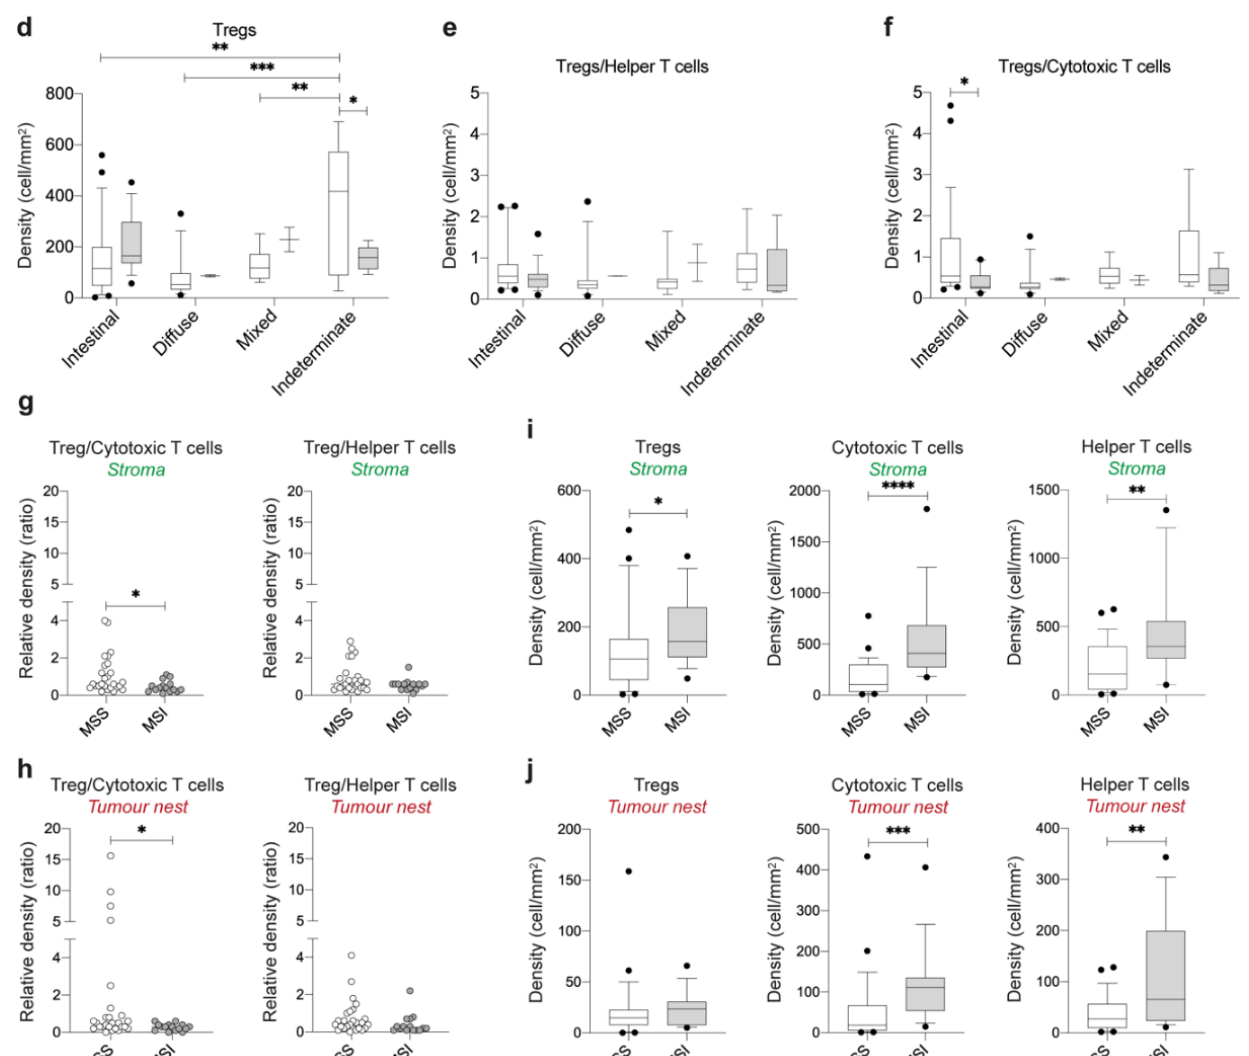
Figure 2. Distribution of T cell populations in MSS and microsatellite instability (MSI) GC tumors. ( a ) Relative and absolute frequency of MSS and MSI cases for each GC histological type. ( b – f ) Relative numbers of helper ( b ), cytotoxic T cells ( c ), Tregs ( d ), and Tregs normalized to helper T cells ( e ) and cytotoxic T cells ( f ), according to the MSI status and tumor histology. ( g , h ) Relative number of Tregs normalized to cytotoxic and helper T cells within the stroma ( g ) and tumor nest ( h ) areas of intestinal-type GC cases, according to MSI status. Relative number of Tregs, cytotoxic T cells, and helper T cells within the stroma ( i ) and tumor nest ( j ) areas of intestinal-type GC cases, according to MSI status. See Supplementary Figure S1 for a visual description of stroma and tumor nest areas. Box and whiskers represent median ± 10 to 90 percentile. * p < 0.05, ** p < 0.01, *** p < 0.001, **** p < 0.0001. Two-way ANOVA with Tukey’s/Sidak’s multiple comparisons test ( b – f ) and Mann–Whitney U test ( g – j ).